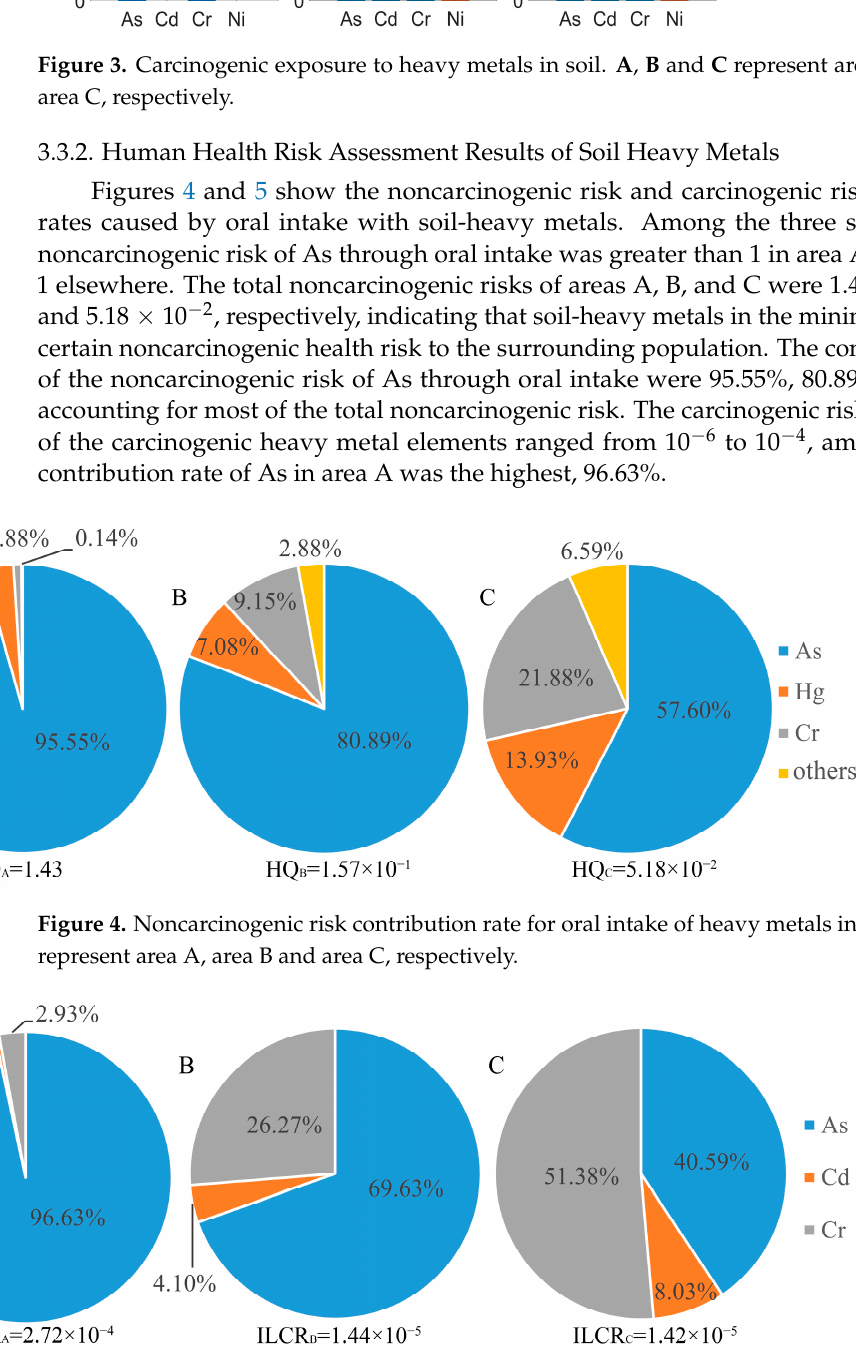
Figure 5. Carcinogenic risk contribution rate for oral intake of heavy metals in soil. A , B and C represent area A, area B and area C,